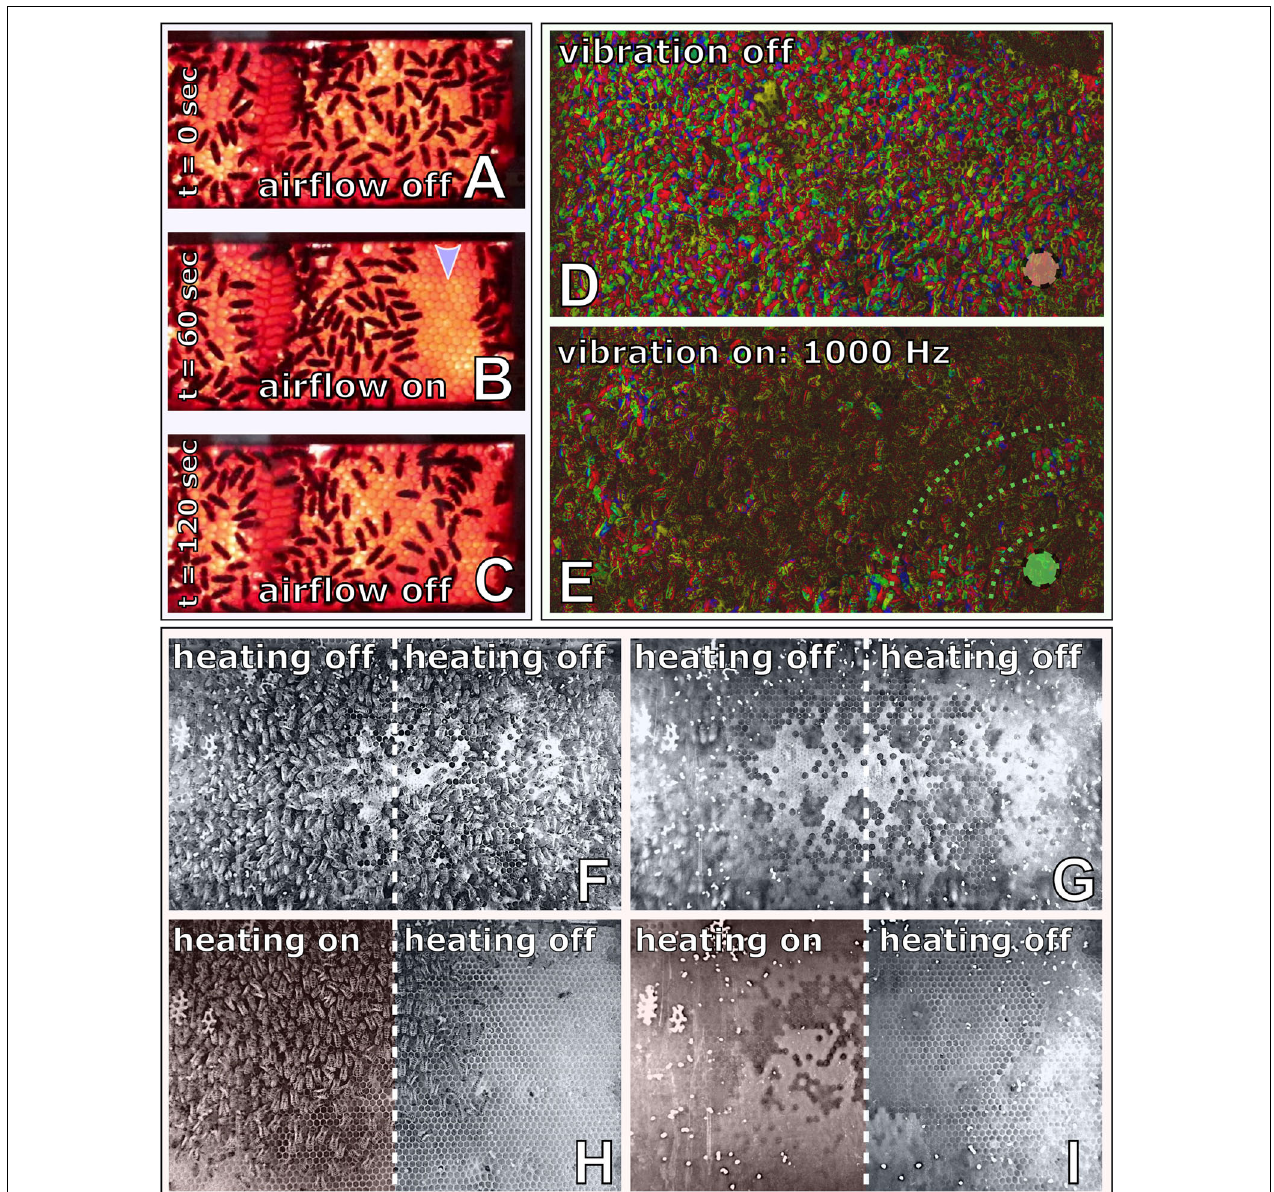
FIGURE 13 | Effects of three stimulus types, which were first investigated on honeybees under laboratory conditions, now employed in the context of a full beehive in the wild. Subfigures show the effect of these stimuli in a “before/after” type comparison. ( A–C) The guided dispersal through airflow: (A) the distribution of bees before the stimulus, (B) how the bees react to the stimulus (the arrow shows the location of the airflow), and (C) the bee redistribution after the stimulus has ended. (D,E) The activity modulation by vibration signals, visualising the movement on the honeycomb over three points in time (with a difference of approximately 2 s). Each colour channel (red, green, and blue) represents the bee positions at one point in time. A lot of movement results in a colourful picture; few movement results in a dark picture. (D) Normal movement on the honeycomb over a timespan of 4 s, no artificial vibrational signal. (E) A 1,000-Hz vibration signal that leads to significantly less movement over 4 s. (F,G) Influencing behaviour through temperature signals: (F) shows the bee distribution on a comb without active heat supply (day 0), bees are distributed over the entire honeycomb, (G) the distribution of the brood nest area, bright spots indicate capped brood cells containing larvae, distributed over the entire honeycomb (day 150). (H) The bee distribution on a comb with active heat supply on the left side (marked red, day 150); bees are mainly on the left honeycomb side. (I) The distribution of the brood nest area after active heat supply on the left side; bright spots indicate capped brood cells, predominantly on the left side of the comb (day 60). (G,I) Cells were made visible by background extraction of a stack of comb